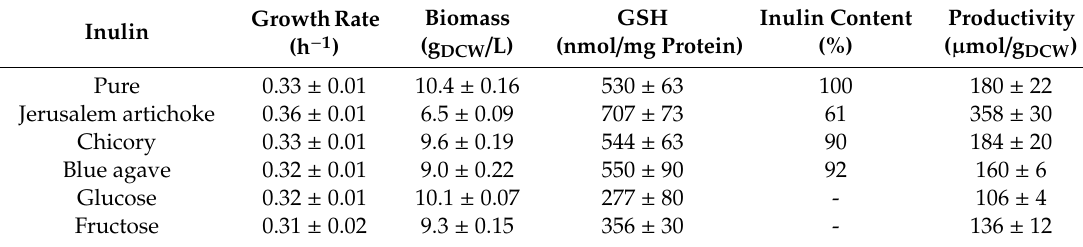
Table 3. Dynamics of GSH and biomass production of strain RIY389 (pTEF-ylGSH1-ylGSH2-INU1) during culture in a shake flask in YNB medium supplemented with glucose, fructose or di ff erent inulin extracts. Growth rate was calculated between 4 and 22 h of culture; GSH and biomass values were determined after 48 h of culture. Data are the mean and standard deviation of triplicate experiments. Inulin